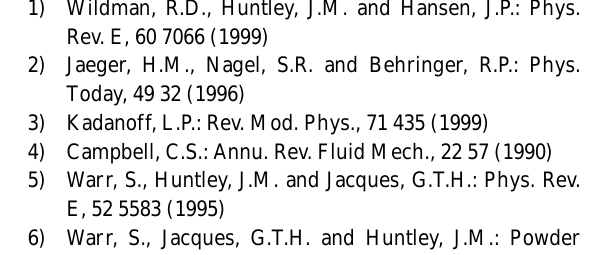
Figure 11 . Though the diffusion coefficient of a par- ticle through particles of a different phase is usually referred to as the mutual diffusion coefficient, in this case it is a composite of both the mutual and self-dif- fusion coefficients, since the particle collides with other particles of both phases. The fact that the frac- tion of each phase varies as a function of height means that the relative dominance of the self-diffu- sion and mutual diffusion components also varies. As expected, the fact that each phase has its own packing fraction and granular temperature profile results in differing diffusion coefficients for the two phases.